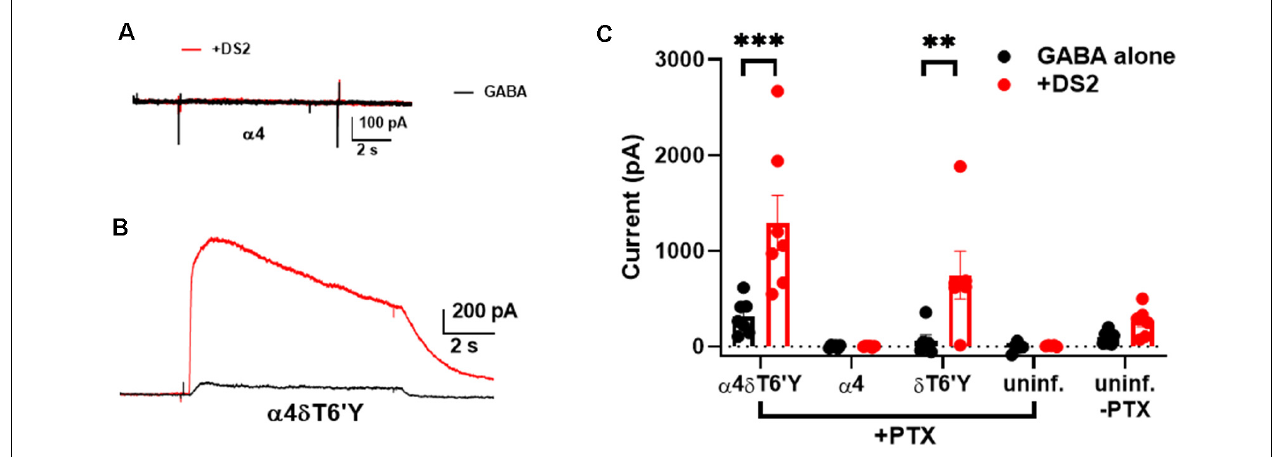
FIGURE 4 | Viral overexpression of δ T6’Y mutation, along with WT α 4 subunit, yields DS2-sensitive, PTX-insensitive GABA current in rat hippocampal cultures. All data were collected in the presence of 50 µ M PTX except for the far pair of bars in panel (C) . (A,B) Representative responses to 0.2 µ M GABA from a neuron transduced with α 4 subunit and from a neuron transduced with both α 4 and δ T6’Y virus as indicated. The α 4 virus alone condition demonstrates that there is no breakthrough GABA current in the presence of PTX. DS2 (1 µ M) enhanced the GABA response in δ T6’Y-containing receptors, indicating functional δ T6’Y expression. (C) Summary of GABA currents following indicated viral transduction. Colors illustrate GABA (in black) application and co-application with 1 µ M DS2 (in red). The weak DS2 effect in non-transduced cultures without PTX indicates low δ expression at baseline. ∗∗ p < 0.01, ∗∗∗ p <